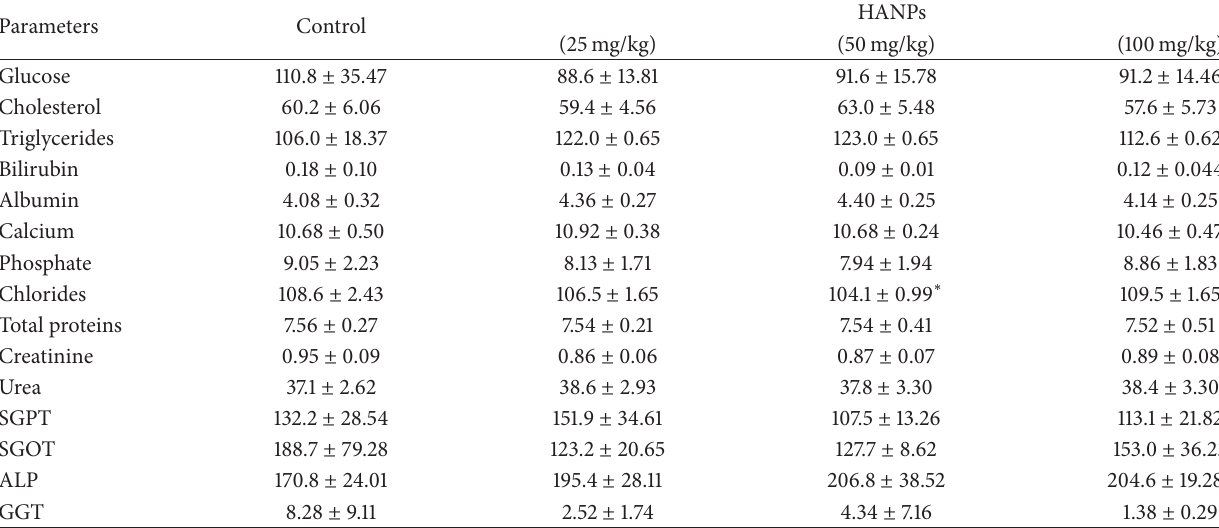
Table 3: Biochemical values of rats when exposed to HANPs (mean ± SD, 𝑛 = 5 ).